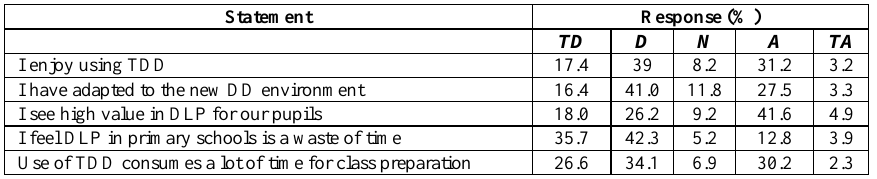
Table 1. Teachers Responses on psychological readiness to DLP